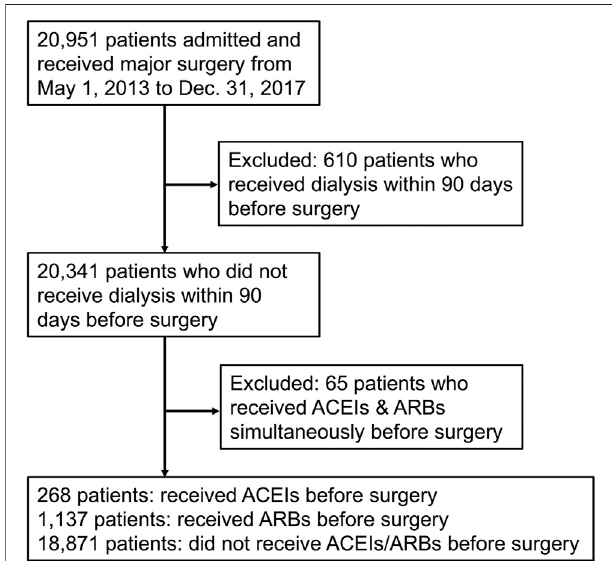
FIGURE 1 | Flow diagram of enrollees. Abbreviations: ACEIs: angiotensin-converting-enzyme inhibitors; ARBs: angiotensin receptor